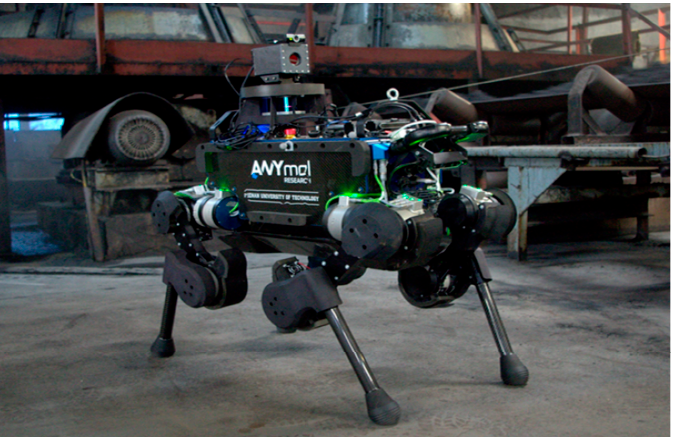
Figure 12. ANYmal legged mine inspection robot by ANYbotics (Reprinted from Ref. [112]).